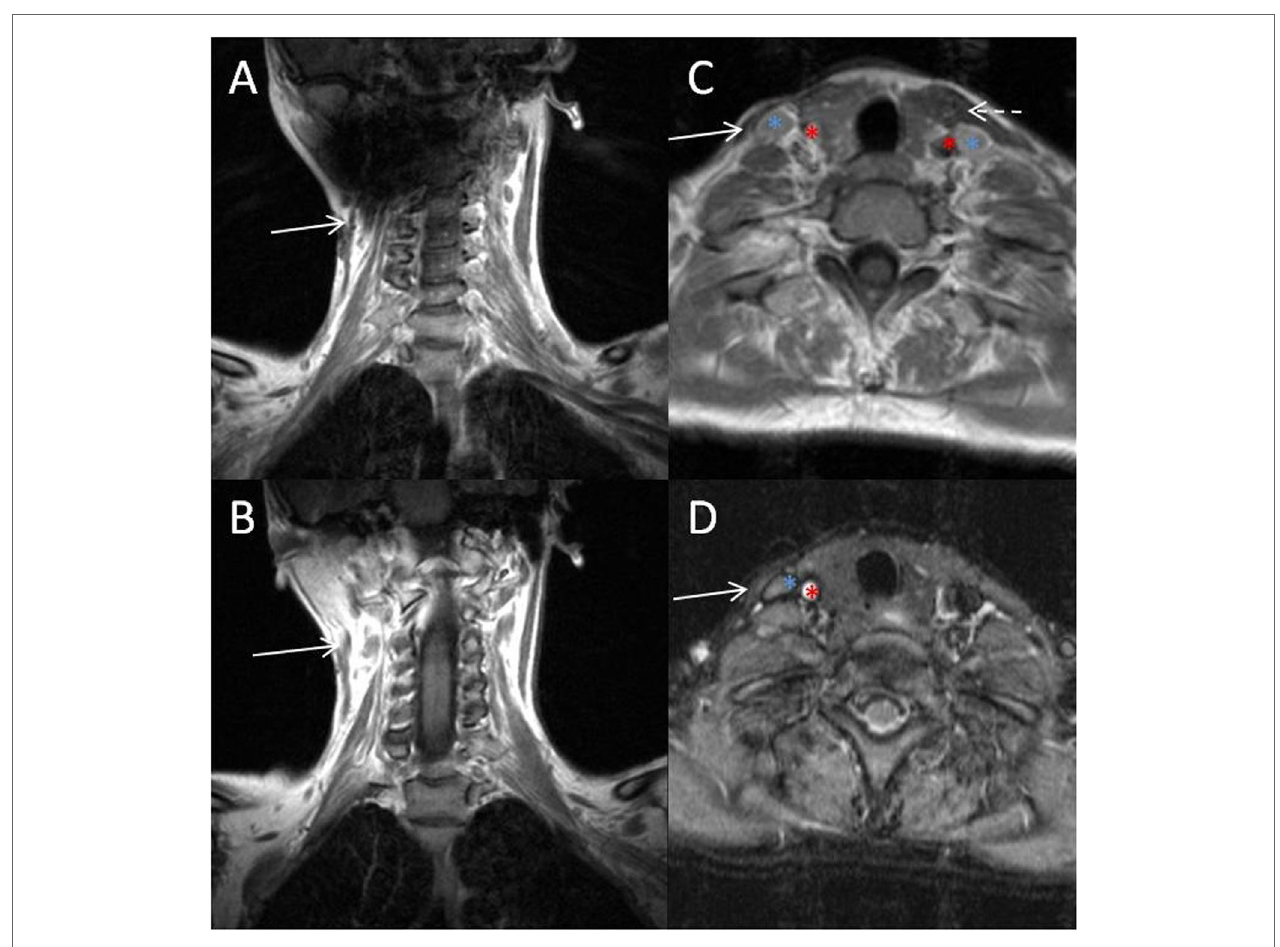
FIGURe 2 | MRI of fibrotic band and remnant sCM. Sequential coronal (a,B) and axial (C,D) images of the fibrotic band (solid arrow) on coronal sequences, remnant SCM (solid arrow) on axial images and the carotid artery (red asterisk), internal jugular vein (blue asterisk), and left SCM (dashed arrow) are indicated for